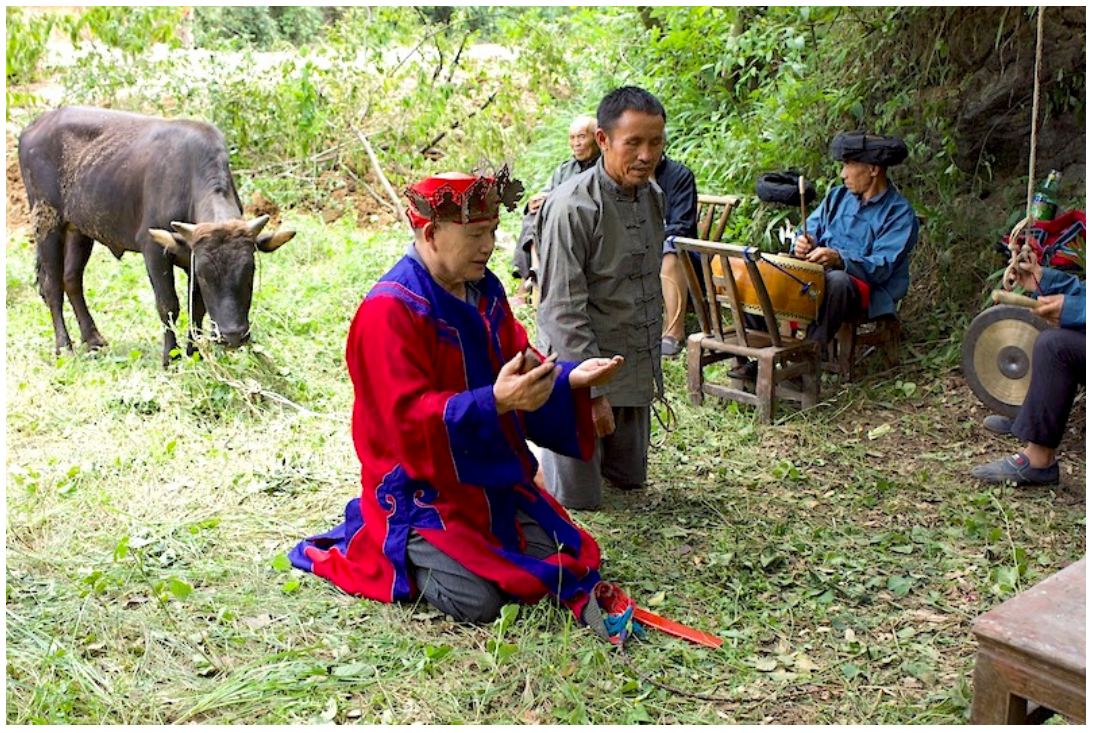
Figure 17. Badai Shi Changwu and offering the water buffalo to the spirits at the outdoor altar. (Photo: Thomas Riccio).